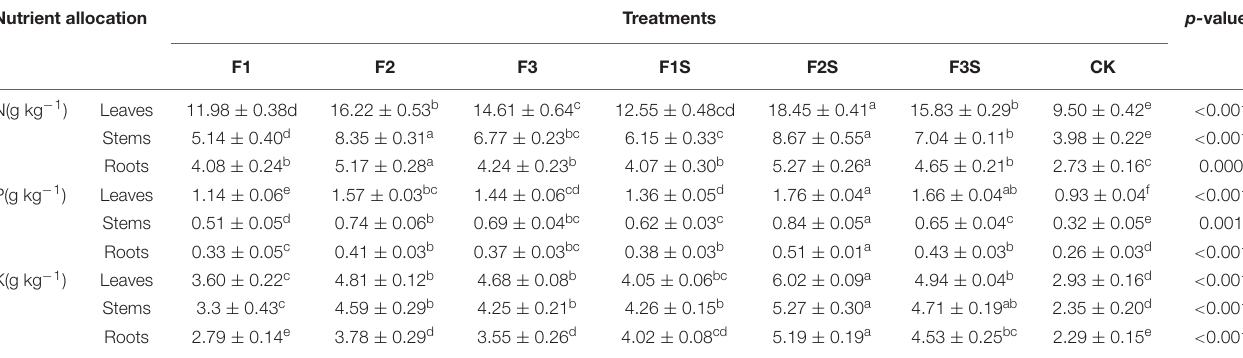
TABLE 4 | N, P, and K content of Pinus massoniana seedlings under different fertilization treatments. Nutrient allocation Treatments